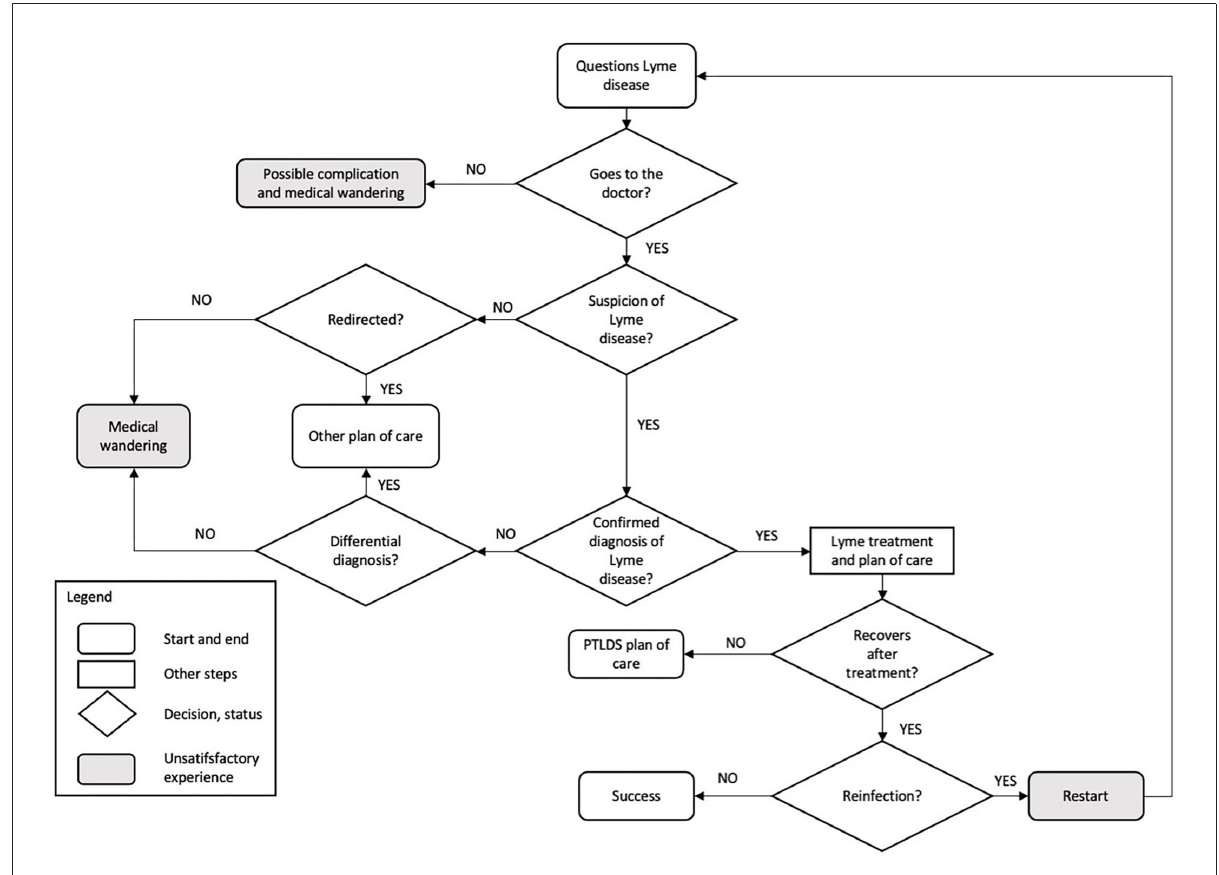
FIGURE3 Itinerary of patients who questioned whether they have Lyme